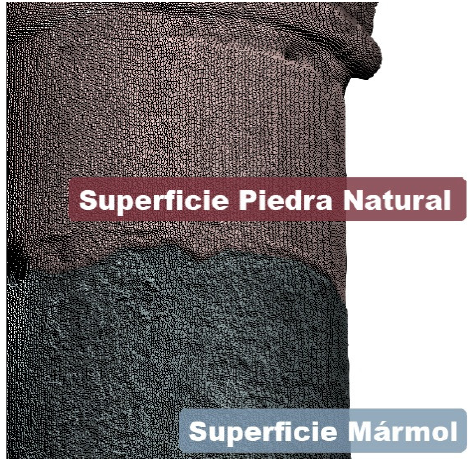
Figure 15. Despite of the model appearance, the finish of the entire shaft is the same for both stones.